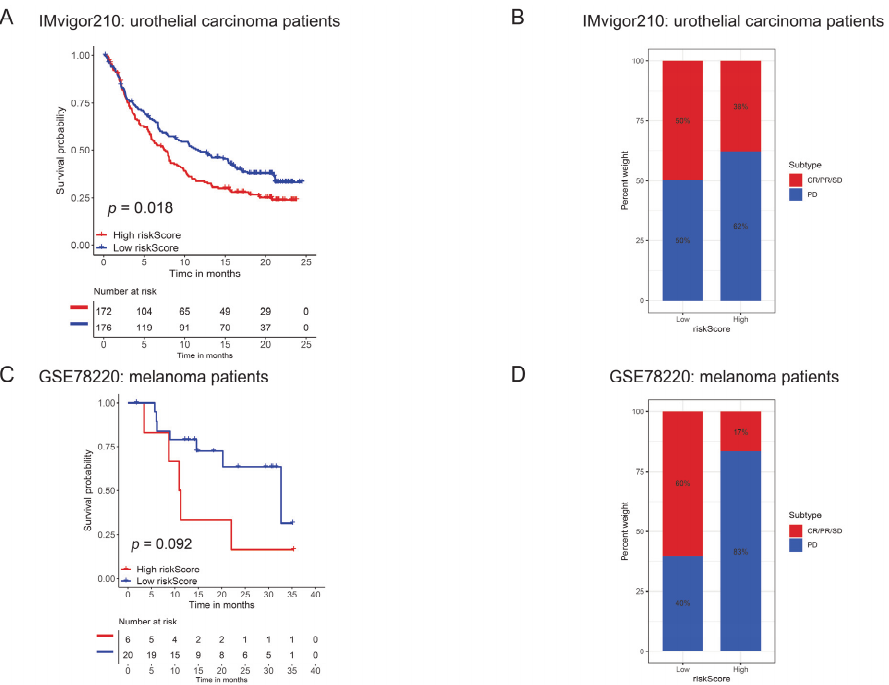
Figure 11. The efficacy of PyroScore in predicting the therapeutic benefits of immune-checkpoint blockade immunotherapy. ( A ) Kaplan–Meier survival plot showed a significant survival benefit in the low PyroScore group of the IMvigor210 cohort (urothelial carcinoma). ( B ) The proportions of clinical response in the low-and high-risk group of the IMvigor210 cohort (urothelial carcinoma). ( C ) Kaplan–Meier survival plot did not show a significant survival difference between the two risk- group of the GSE78220 cohort (melanoma). ( D ) The proportions of clinical response in the low-and high-risk group of the GSE78220 cohort (melanoma). Based on the GDSC database, we evaluated drug sensitivity between different risk score groups. The results showed that patients with low PyroScore were more sensitive (lower IC50) to ABT-263, ABT-888, AG-014699, AICAR, AMG-706, and ATRA (Figure 12). Therefore, we hypothesized that